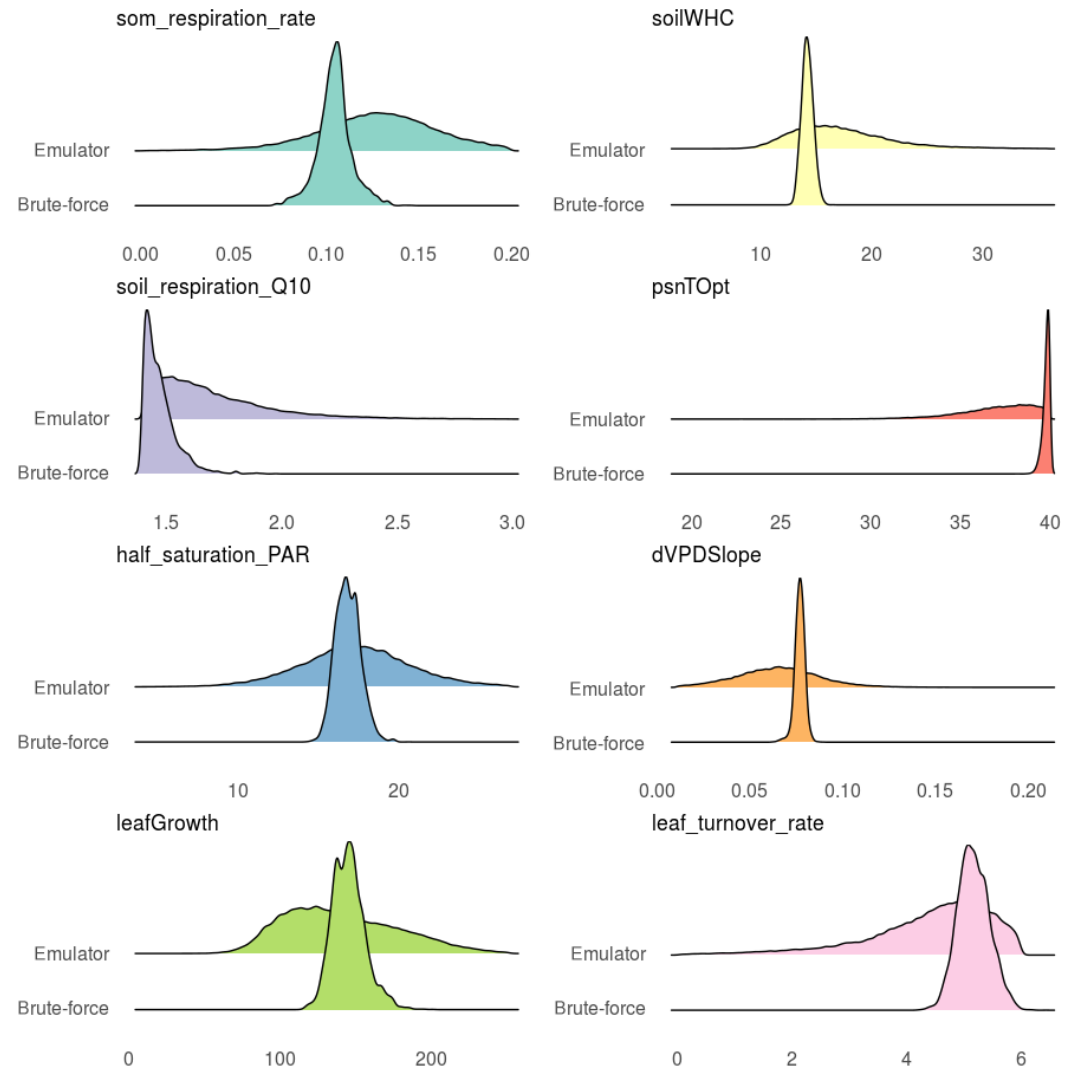
Figure 5. Posteriors from the emulator vs. brute-force approaches with SIPNET after calibration against real-world data. Table 2. Performance statistics of ensemble means before and after the PDA for both models and output variables. While root-mean-square- error (RMSE) scores evaluate the deviations of model predictions from data, deviance ( − 2 × log-likelihood) scores evaluate the goodness of fit under the assumed data model. For both metrics lower scores are